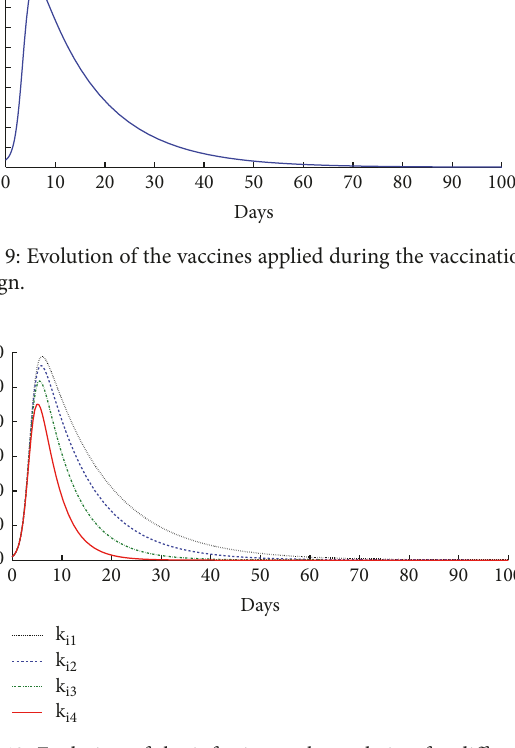
Figure 10: Evolution of the infectious subpopulation for different values of 𝑘 𝑖 .